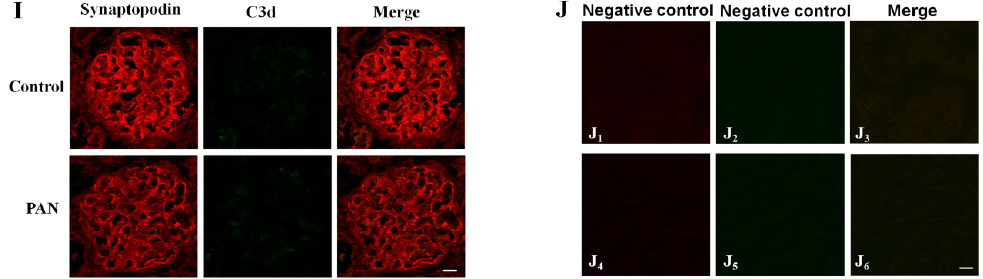
Figure 4. Representative complement immunofluorescent staining in the PAN rat nephropathy model. Immunofluorescent staining of C3 ( A ), DAF ( C ), C3aR ( E ), C1q ( G ), and C3d ( I ), with synaptopodin in a PAN nephropathy rat model. Complement factors are labeled in green, and synaptopodin is labeled in red. Scale bar for overview: 20 μ m; higher magnification: 30 μ m. ( B , D , F , H ) Immunofluorescence staining of C3, C3aR, DAF, and C1q in glomeruli, the positive signals were quantified as the relative fluorescence intensity. Each column represents the mean value that was derived from four glomeruli in a single experiment. The results are presented as the mean value of three independent experiments; ( J ) Images J 1 – 6 are the negative controls by without primary antibodies; images J 1 , 2 , 4 , 5 were incubated with Alexa Fluor ®596 goat anti-mouse IgG, Alexa Fluor ®488 goat anti-rabbit IgG, Alexa Fluor ®596 goat anti-rabbit IgG, and Alexa Fluor ®488 goat anti-mouse IgG, respectively. Data are presented as means ± SD. * p < 0.05 vs. control group; # p < 0.01 vs. control group.